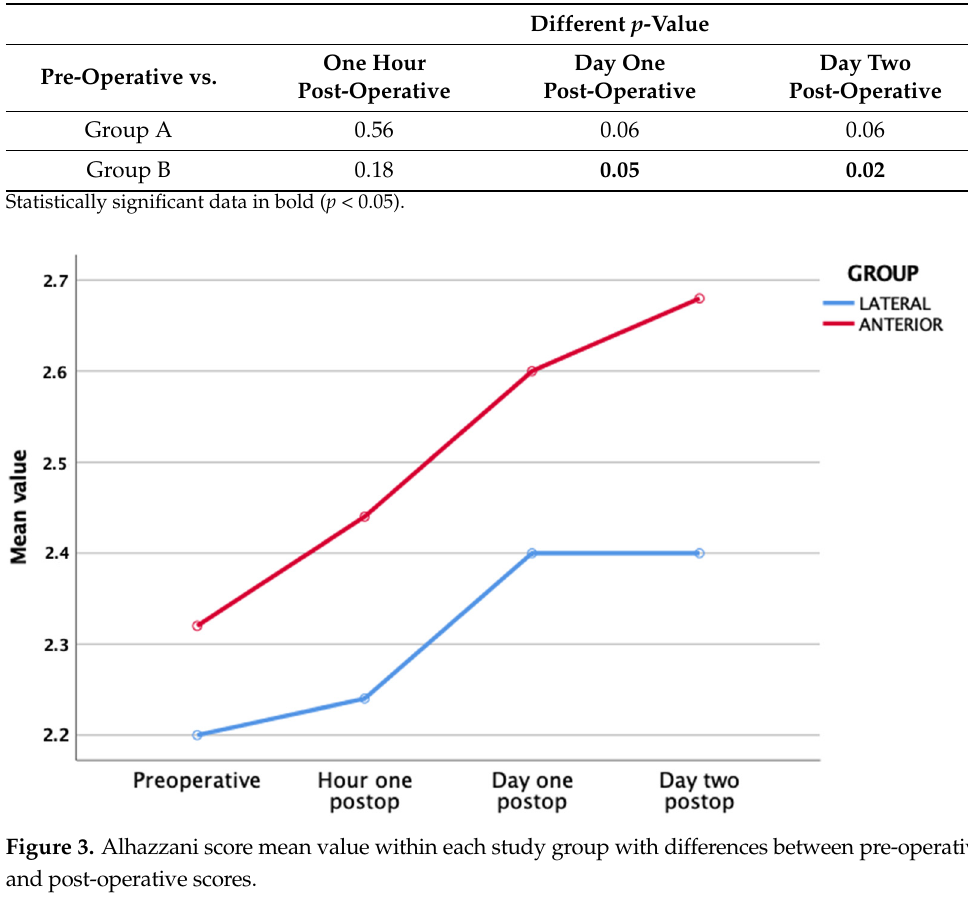
Table 6. Rho Spearman’s correlation between pre-operative Alhazzani score and Hemoglobin serum level at different times for study group. Spearman’s Rank Correlation Coefficient p -Value Pre-operative vs. 0.78 0.041 One hour Post-operative 0.34 0.136 Day One Post-operative 0.03 0.315 Day Two Post-operative 0.02 0.333 Statistically significant data in bold ( p < 0.05). Table 7 reported the differences between the variables within each group. Table 7. Differences between variables within each study group (Wilcoxon test and Related-Sam- ples Friedman’s test Two-Way Analysis of Variance; HHb: hemoglobin subunit beta). Different Time p -Value Pre-operative vs. Hour One Hour One vs. Day One